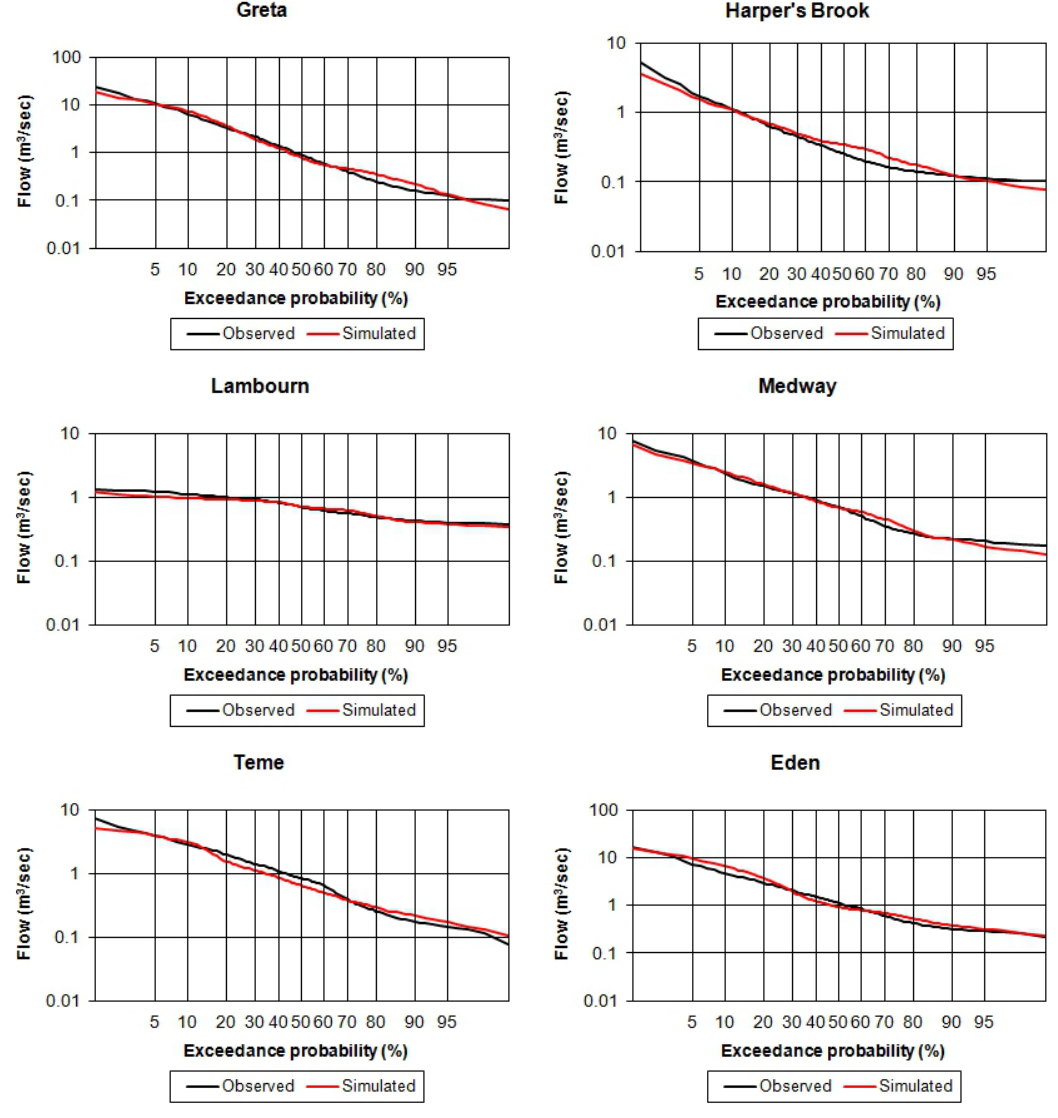
Fig. 2. Observed and simulated flow duration curves for each catchment, over the calibration period (1980–1983).